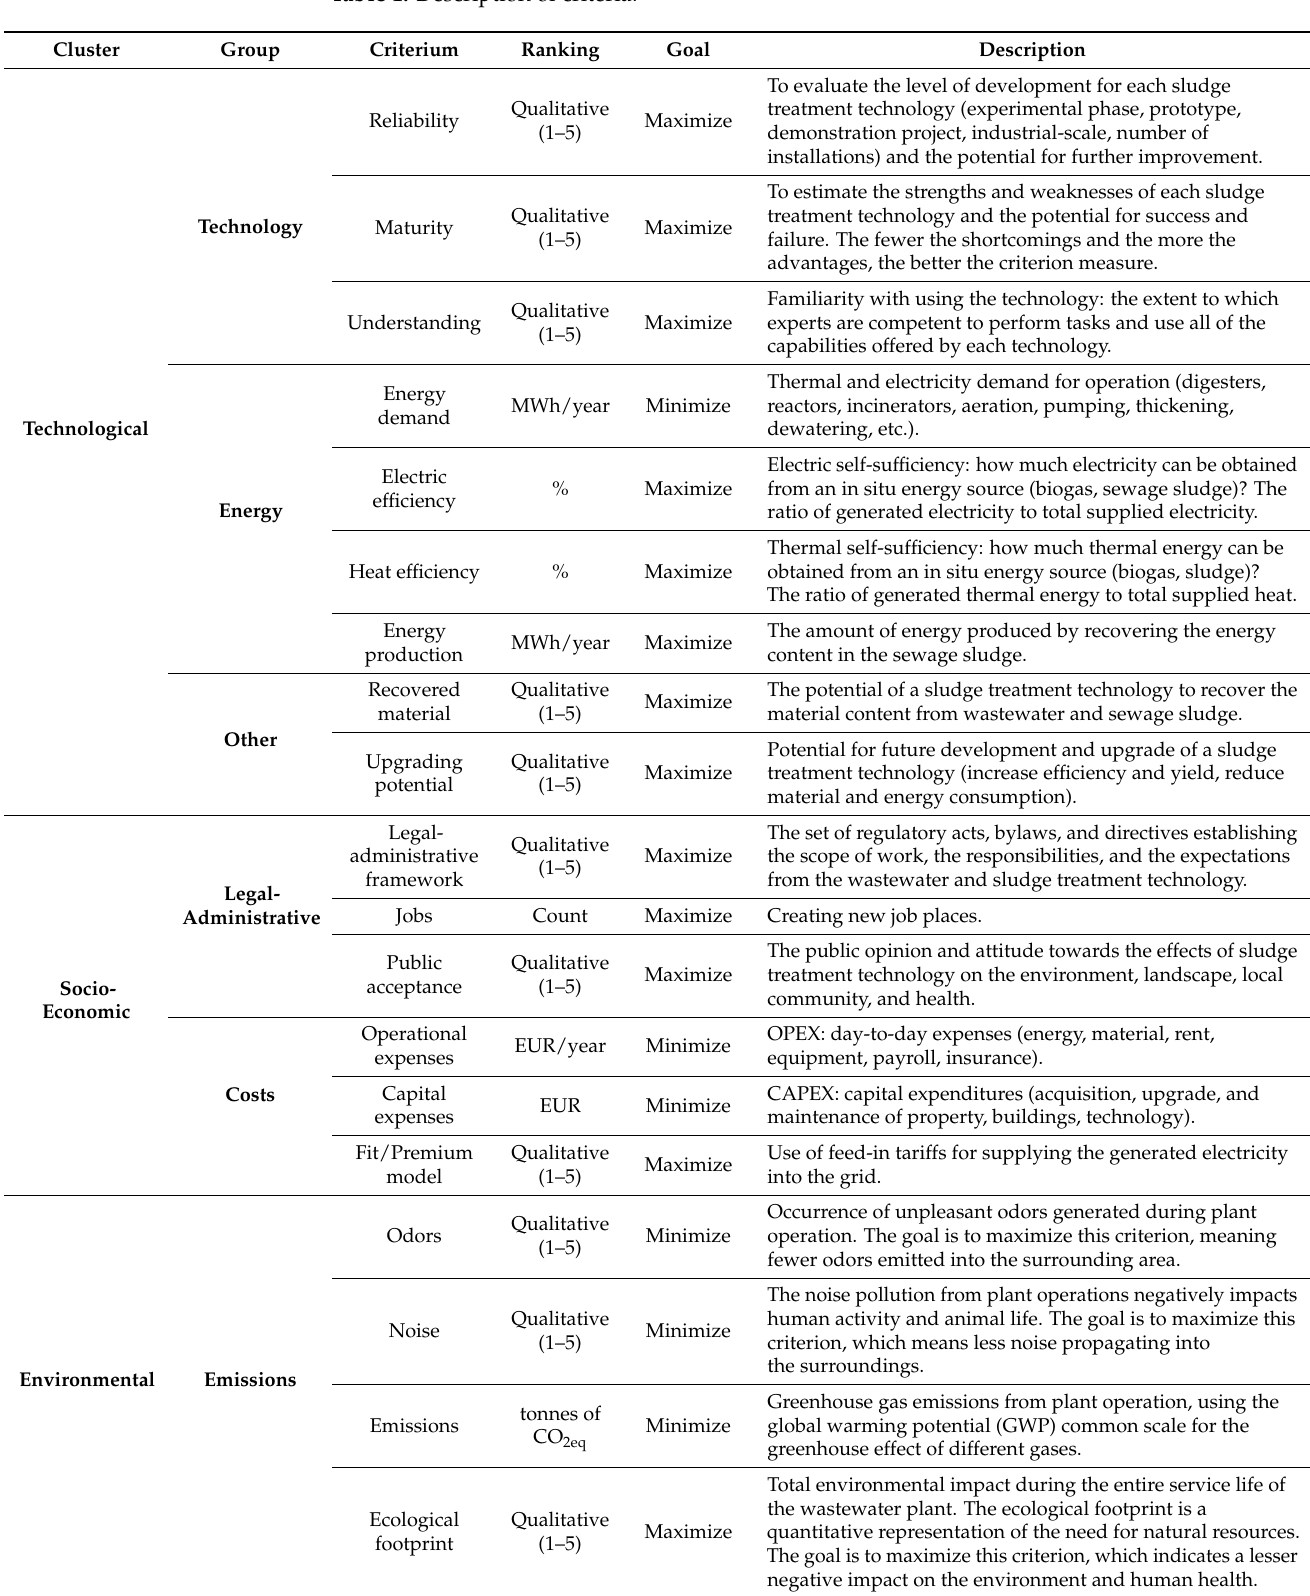
Table 1. Description of